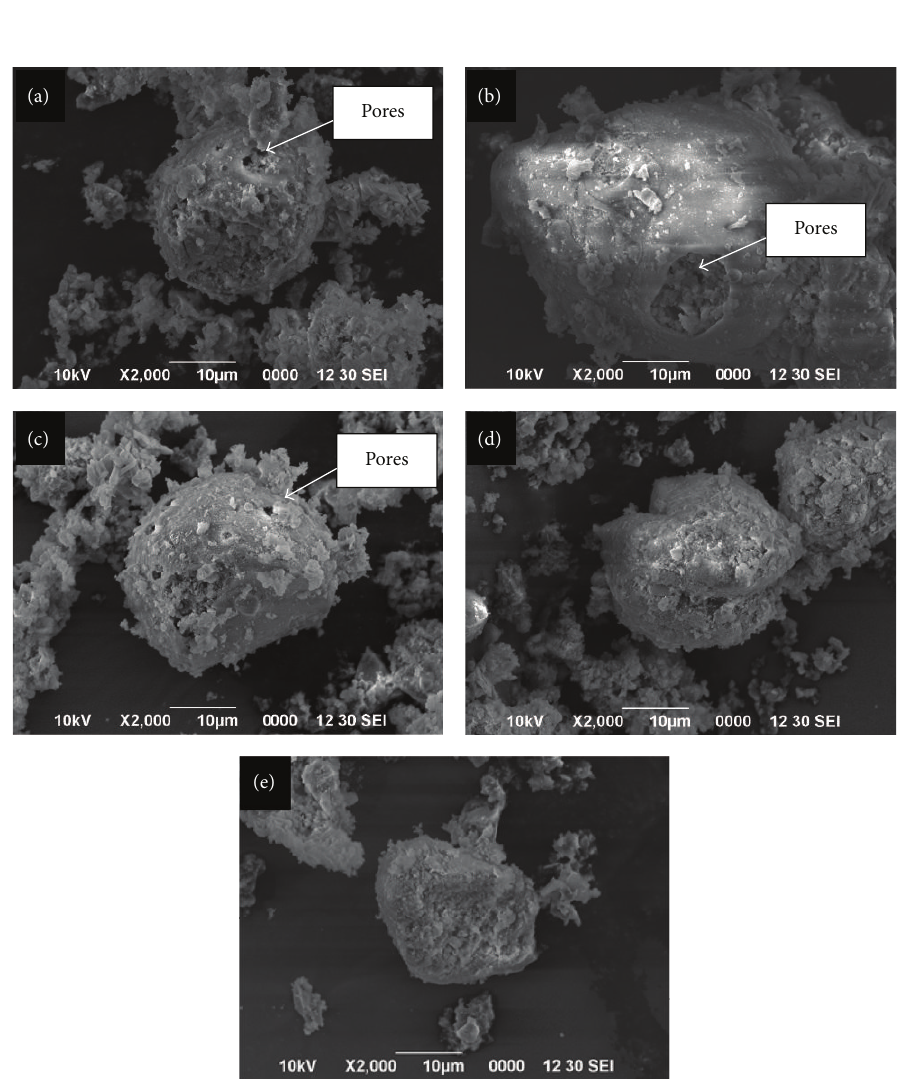
Figure 5: SEM images of POFA collected at distances (a) 2 m, (b) 4m, (c) 6 m, (d) 8m, and (e) 10m of the wind